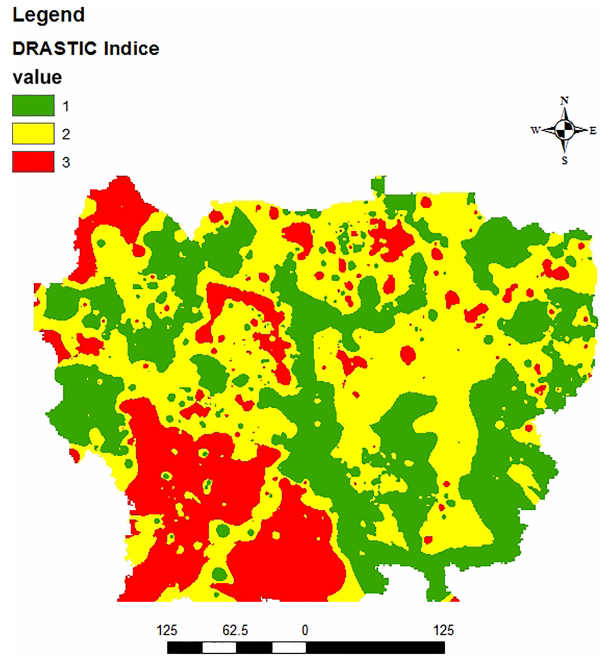
Figure 11. DRASTIC vulnerability map.